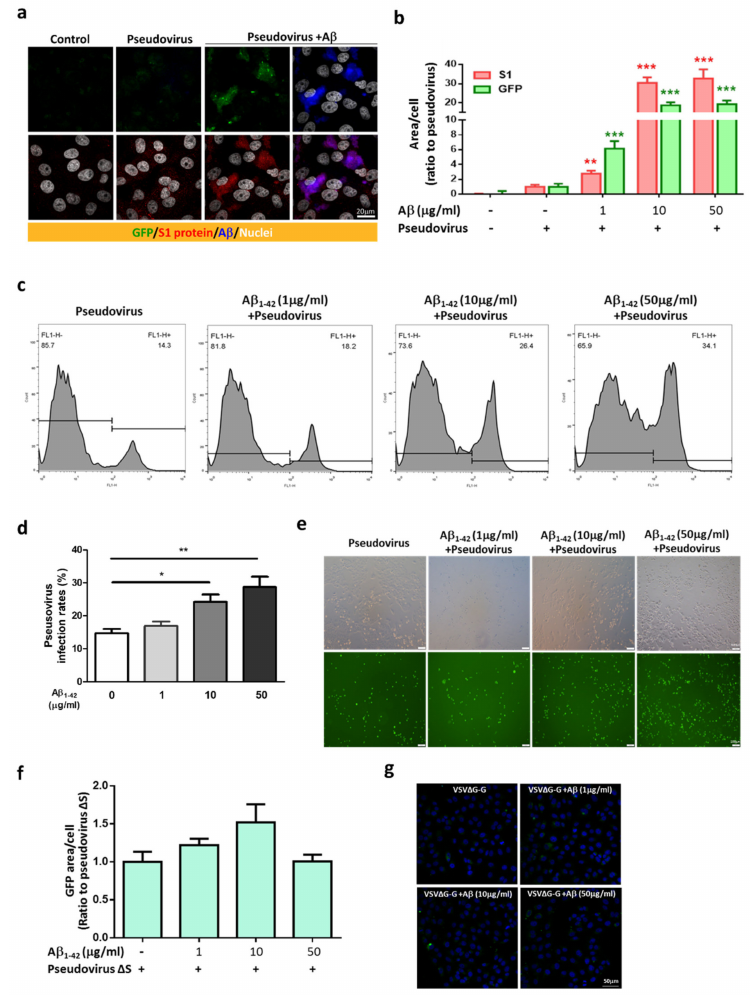
Figure 3. A β 1-42 increases the infectivity of SARS-CoV-2 pseudovirus. ( a ) GFP fluorescence of SARS-CoV-2 (green, upper panels) and immuno-reactivity of the S1 of SARS-CoV-2 (red, lower panels) were barely detected 2 h post-infection in Vero E6 cells with vehicle (control) or SARS-CoV-2 pseudovirus alone (pseudovirus), which were robustly elevated in the infected cells with A β 1-42 treatment (pseudovirus+A β ). Intriguingly, A β 1-42 (blue) was co-localized with the immuno- reactivity of the S1 of SARS-CoV-2 (shown as purple in right lower image). Scale bar: 20 µ m. ( b ) Quantification of GFP fluorescence and the S1 immuno-reactivity in Vero E6 cells with viral infection and A β 1-42 treatments is shown. A β 1-42 (1 µ g/mL) significantly increased GFP expression (6.15 ± 1.02-fold increase compared to the control, p < 0.001) and S1 immuno-reactivity (2.77 ± 0.41-fold increase compared to control, p < 0.01). Further increases in GFP expression and S1 immuno-reactivity were found at 10 µ g/mL (18.71 ± 1.58-fold increase compared to the control, p < 0.001, and 30.41 ± 2.91-fold increase compared to control, p < 0.001, respectively) and 50 µ g/mL of A β 1-42 (19.3 ± 1.88-fold increase compared to the control, p < 0.001, and 32.69 ± 4.79-fold increase compared to the control, p < 0.001, respectively). ( c ) Representative histograms of flow cytometry indicated that A β 1-42 (1 to 50 µ g/mL) increased GFP fluorescence (% total counts) in cells. ( d ) Quantification of the viral infectivity from flow cytometry is presented as infection rates (%, for details, please see Materials and Methods). The infection rates for cells treated with A β 1-42 at doses of 1, 10, and 50 µ g/mL were 16.87% ± 1.32% (ns), 24.22% ± 2.24% (* p < 0.05), and 28.7% ± 3.2% (** p < 0.01), respectively, compared to the controls (14.65% ± 1.32%; n = 6 per group). ( e ) Representative photomicrographs of phase contrast (upper panels) and fluorescent images (lower panels) are presented. Scale bars: 100 µ m. ( f ) Viral infectivity of pseudovirus VSV ∆ G-G was measured by total GFP fluorescence with DAPI by confocal microscopy in Vero E6 cells. Treatment with A β 1-42 (0, 1, 10, 50 µ g/mL) did not significantly increase viral infection of pseudovirus VSV ∆ G-G in Vero E6 cells after a 2 h incubation ( p = 0.0571). ( g ) Representative confocal images indicated that the expression of GFP was minimal after co-treatment with pseudovirus VSV ∆ G-G and A β 1-42 . Scale bar: 50 µ